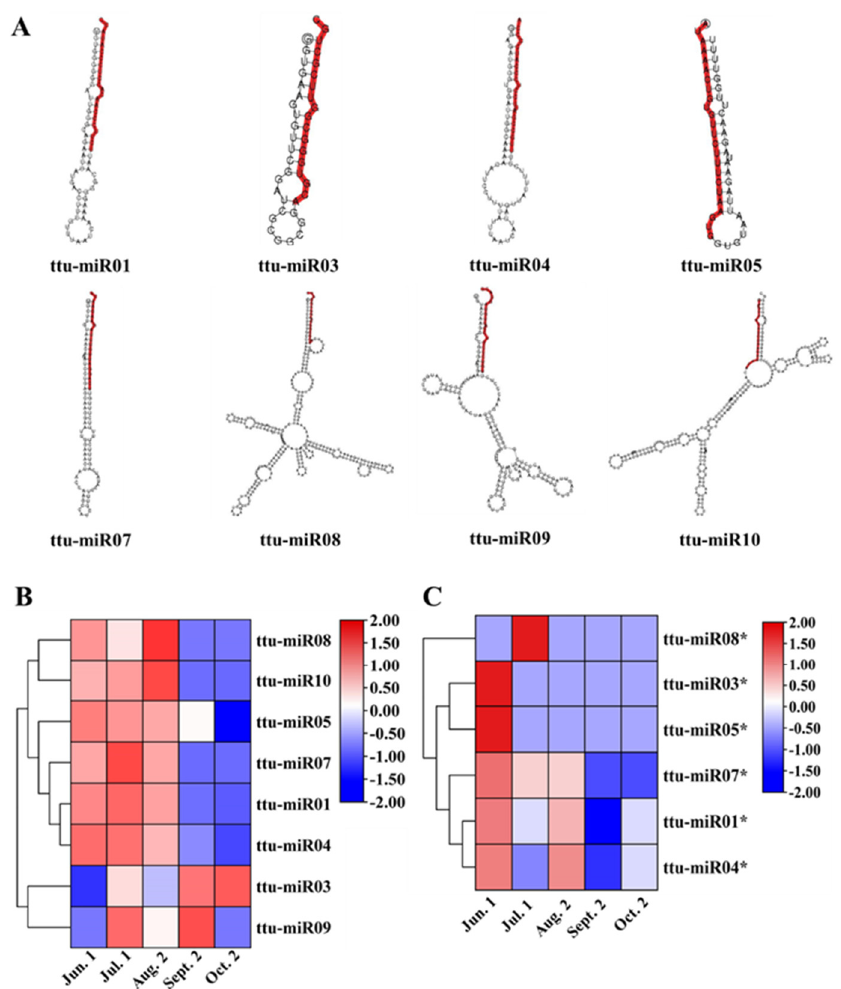
Figure 2. Characterization of novel miRNAs obtained from T. tuan seed. ( A ) Examples of stem-loop hairpin secondary structures of predicted novel miRNAs during seed maturation in T. tuan . (Segments corresponding to the mature miRNAs are marked in red). Heat map of expressed novel miRNAs ( B ) and novel miRNAs * ( C ) in T. tuan seed at five maturational stages. Table 4. Summary of mapped mature and hairpin in novel miRNAs.